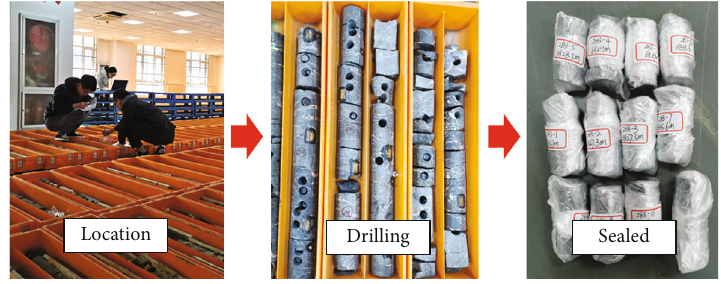
Figure 2: Schematic diagram of the core sampling method of SK-2.